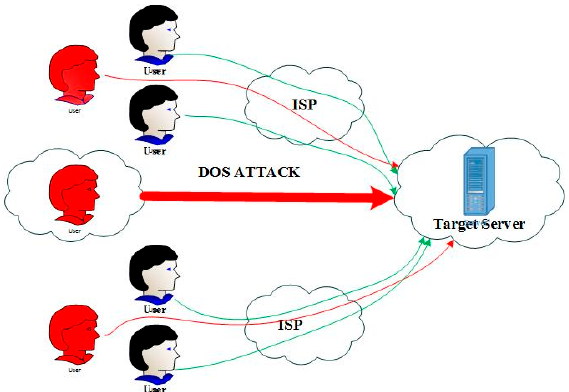
Figure 12. DOS attack demonstration